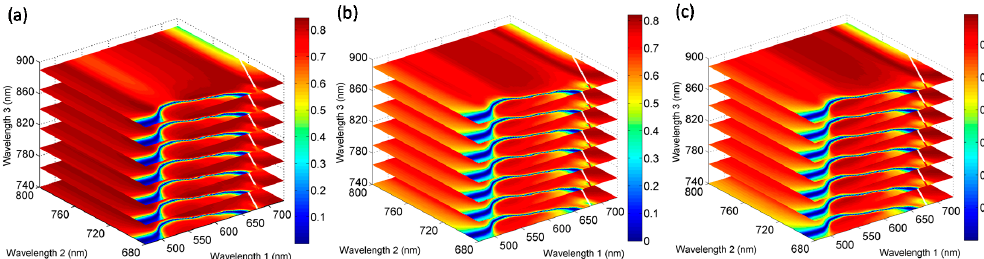
Figure 5. The three-dimensional slice maps of the coefficients of determination (R 2 ) for the relationships between CI-like( λ 1, λ 2, λ 3) indices calculated from all possible three-band combinations in the regions of 470–730 nm ( λ 1, Wavelength 1), 680–800 nm ( λ 2, Wavelength 2) and 740–1000 nm ( λ 3, Wavelength 3) and leaf Chl in: ( a ) the upper-layer; ( b ) the middle-layer; and ( c ) the bottom-layer at +50°, +30° and +20° viewing angles, respectively.